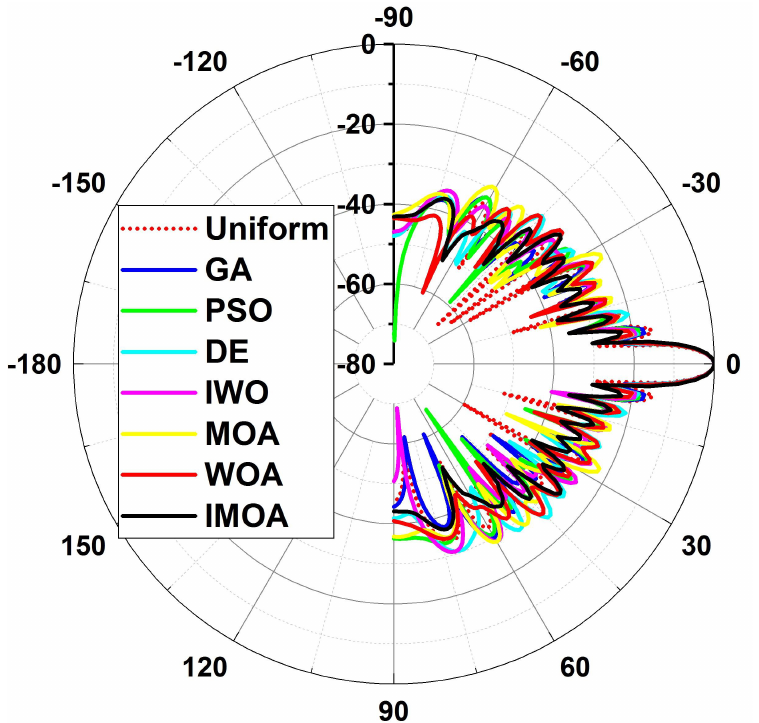
Figure 11. 2D EM simulation